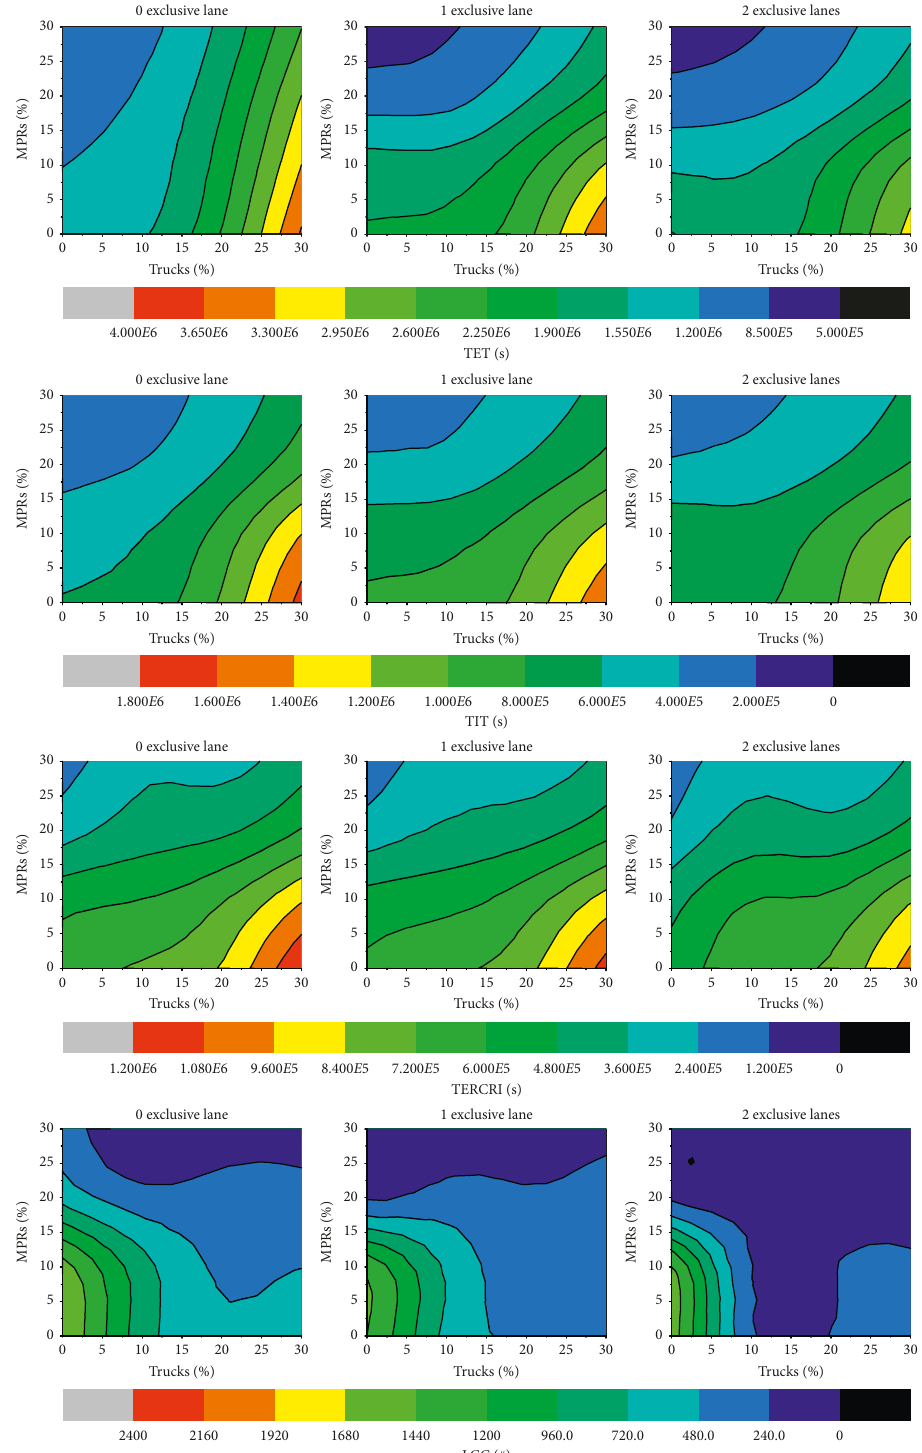
Figure 6: Safety evaluation results of CAV’s exclusive lane on volume �